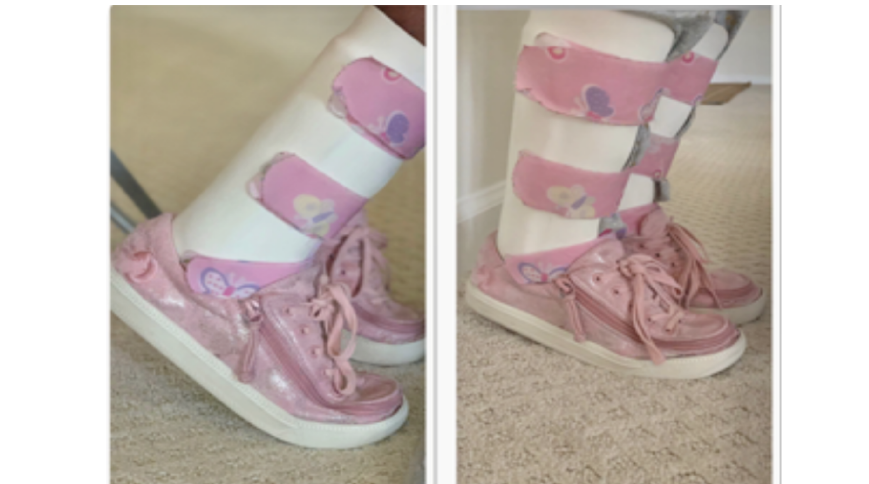
Figure 2. Left image was taken pre-IMES TX and the right image was taken post-IMES TX to the gastrocnemius muscles